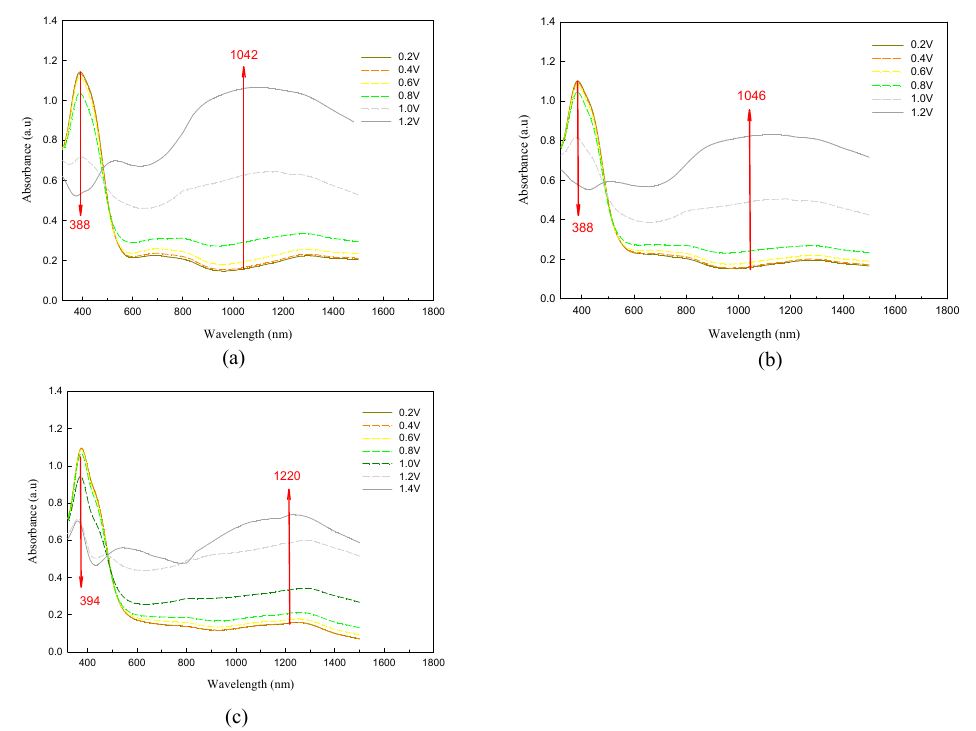
Figure 5. Spectroelectrochemical spectra of P(TTPA- co -DIT) films on ITO electrode at various potentials in an ionic liquid solution. The copolymer films were prepared potentiostatically at: ( a ) 1.0 V; ( b ) 1.1 V; and ( c ) 1.2 V on ITO glass electrodes. Table 1. Absorption peaks of polymer films in ionic liquid solution.